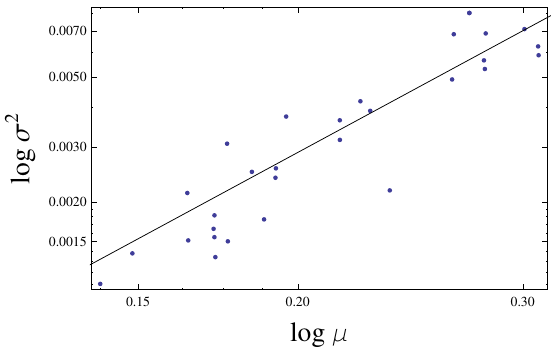
Figure 10. Taylor’s law in the log–log plane at a time-scale equal to one minute for the first configu- ration.